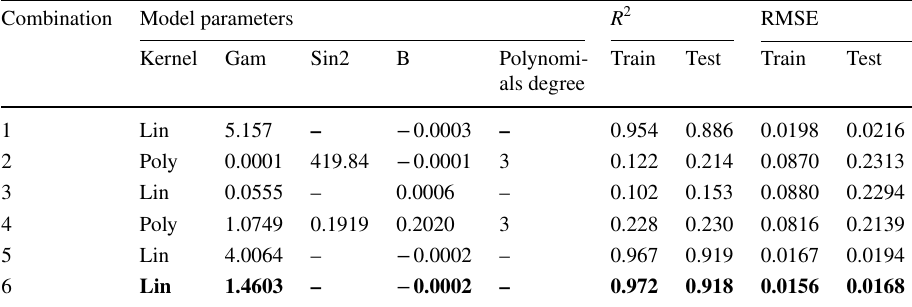
Bold values represent the